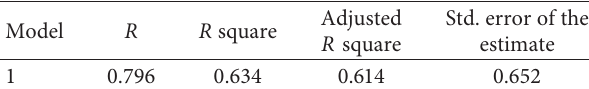
Table 4: Model summary.